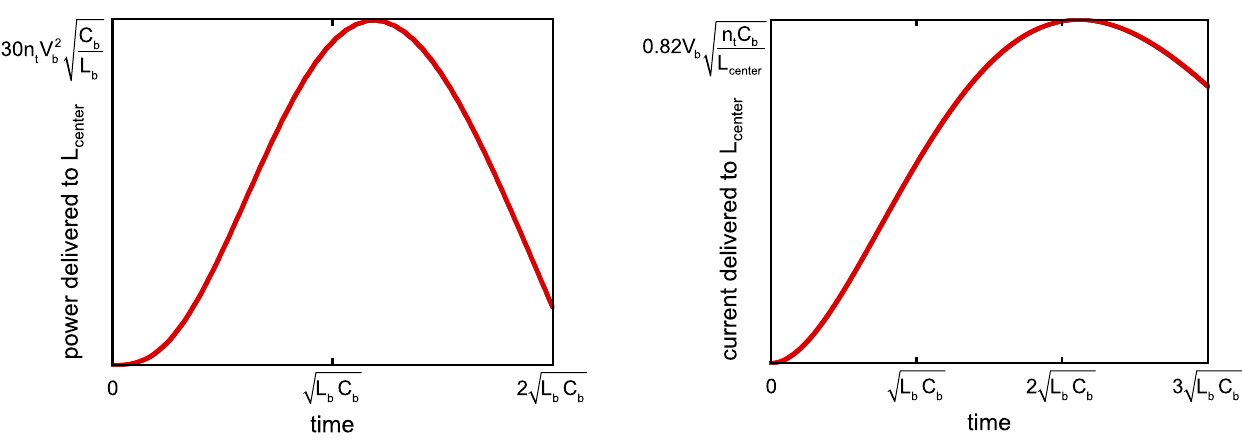
FIG. 17. Time history of the current delivered to the inductance L of the idealized accelerator-circuit model illustrated center by Fig. 15, assuming Eqs. (C7) and